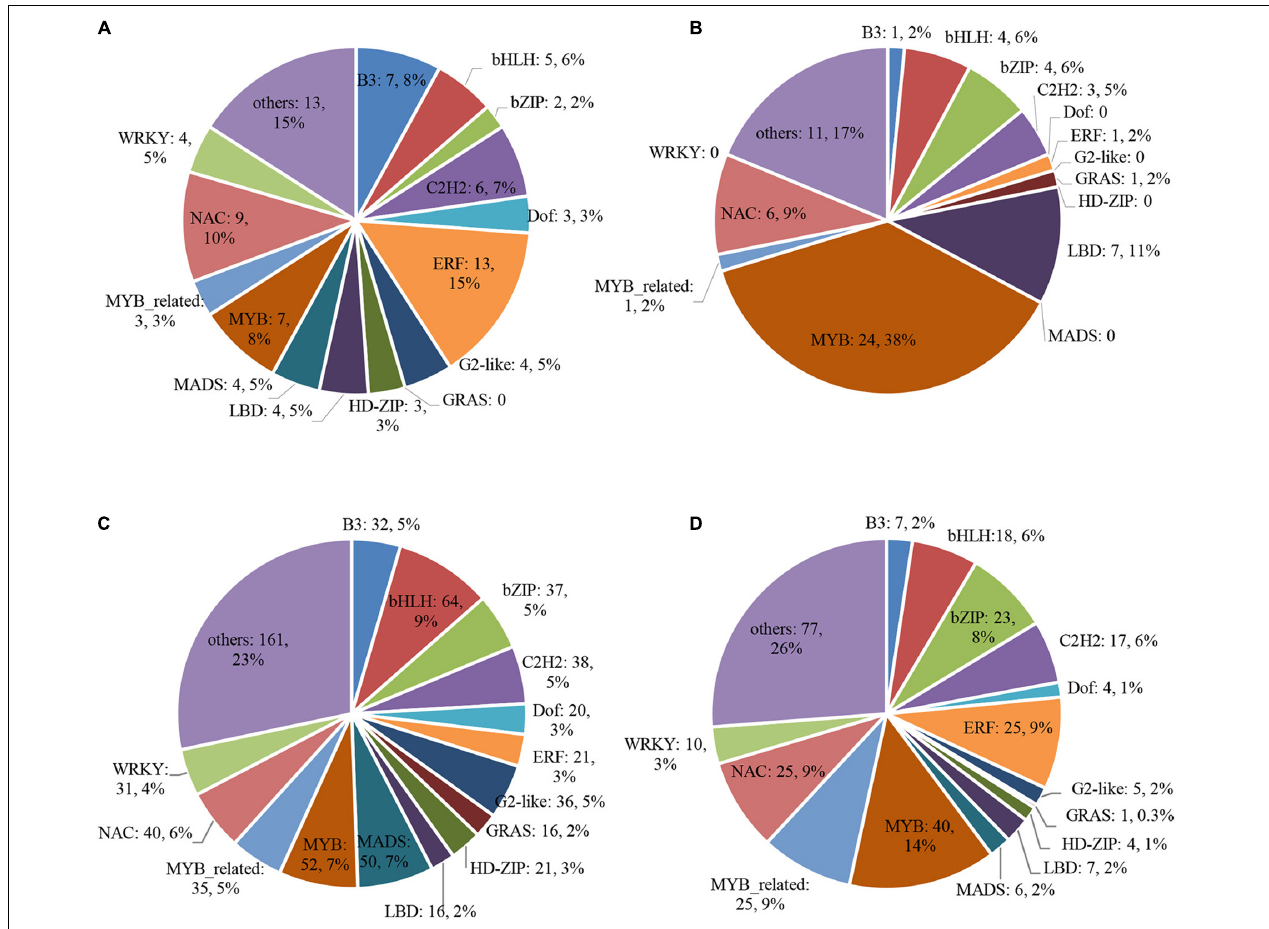
FIGURE 9 | Differentially expressed transcription factor (TF) genes. (A) cluster 1; (B) cluster 2; (C) cluster 3; (D) cluster